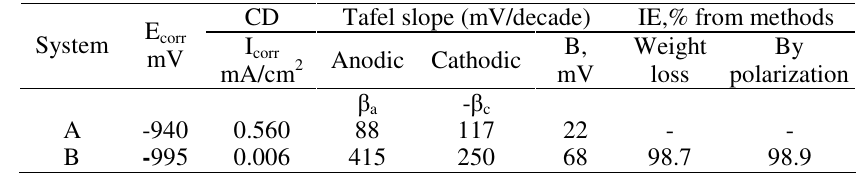
Table 2. Polarisation data and inhibition efficiency (IE) of hexamine for zinc in 0.01 M H